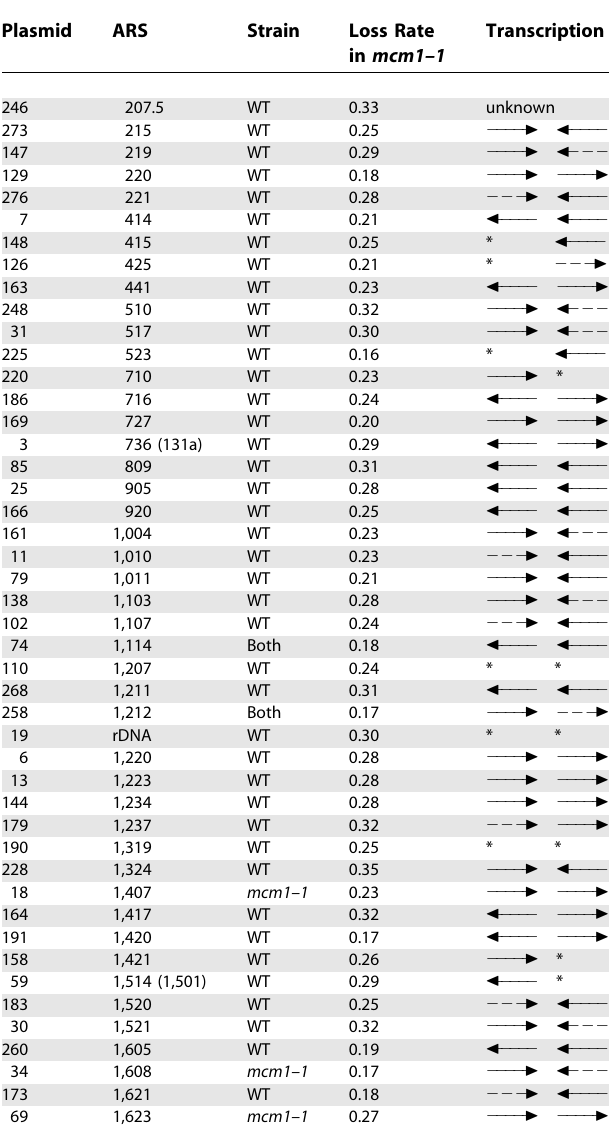
Table 5. Categorization of ARSs Based on Plasmid Loss Rates and Transcriptional Activity